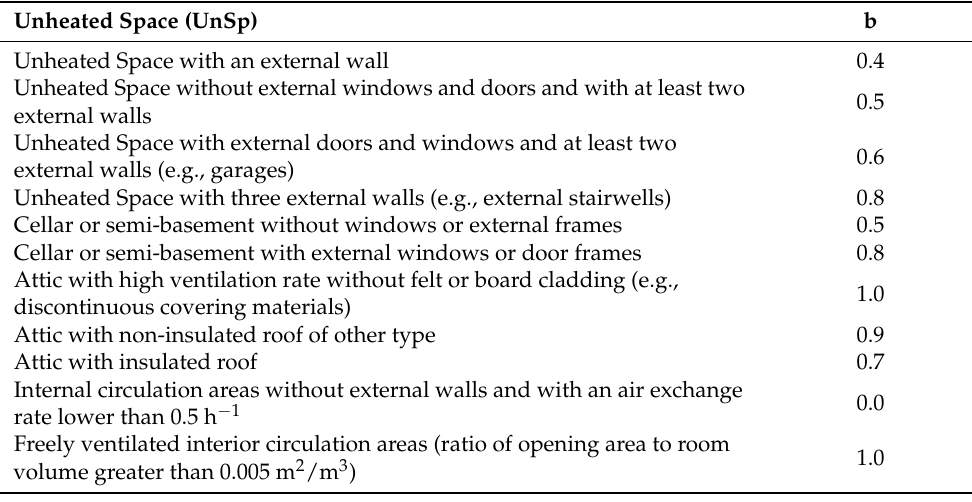
Table 12. Simplified values for the adjustment factor (b), set by UNI/TS (adapted from [17]). Unheated Space (UnSp) b Unheated Space with an external